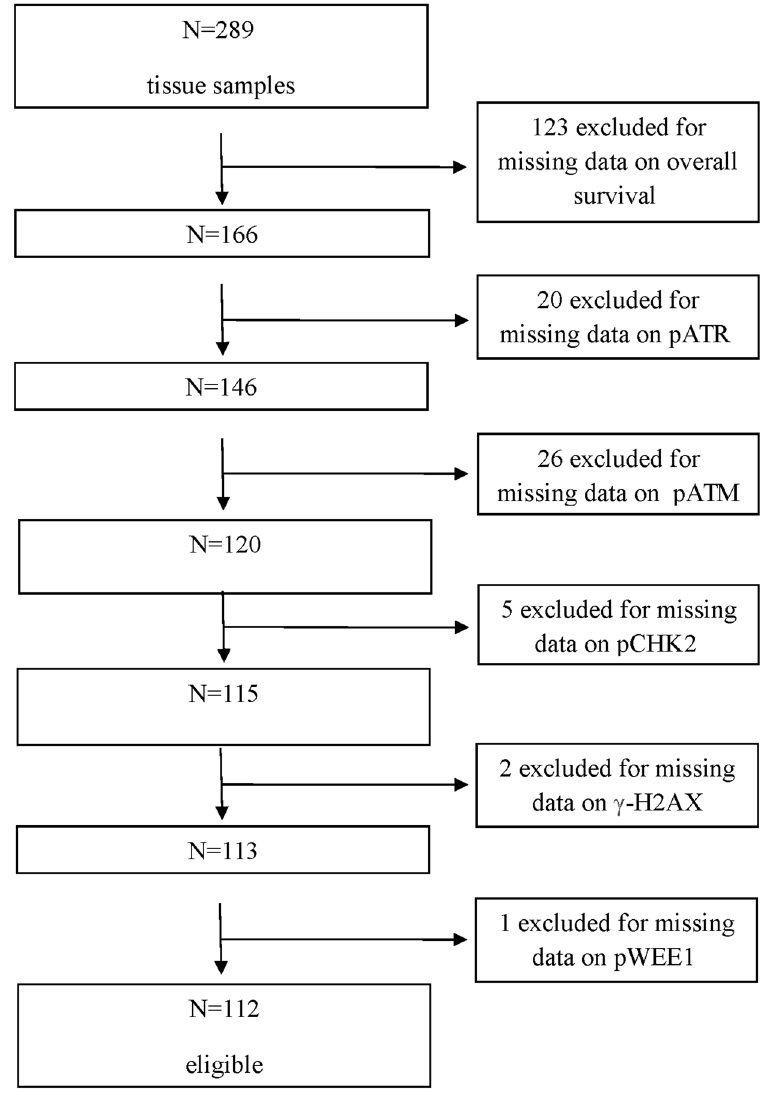
Figure 1. Flow diagram of the patients’ selection